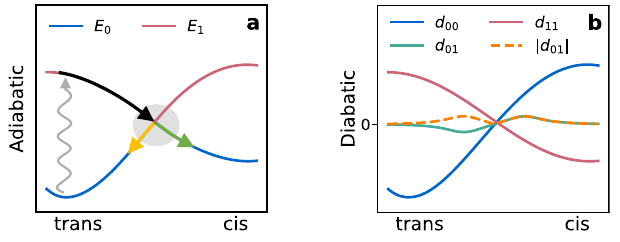
Fig. 1 Depiction of the potential energy surfaces in azobenzene derivatives. a S 0 and S 1 adiabatic energies, with the CI region shaded in gray. Initial excitation is shown with a vertical zigzag line. Trajectories prior to hopping are shown in black. Reactive and unreactive trajectories after hopping are shown in green and yellow, respectively. b Diabatic energies d H nm (cid:1) ð d Þ nm . The diagonal diabatic elements cross and become re-ordered along the isomerization coordinate. A CI occurs when the diagonal diabatic elements cross and the off-diagonal element becomes